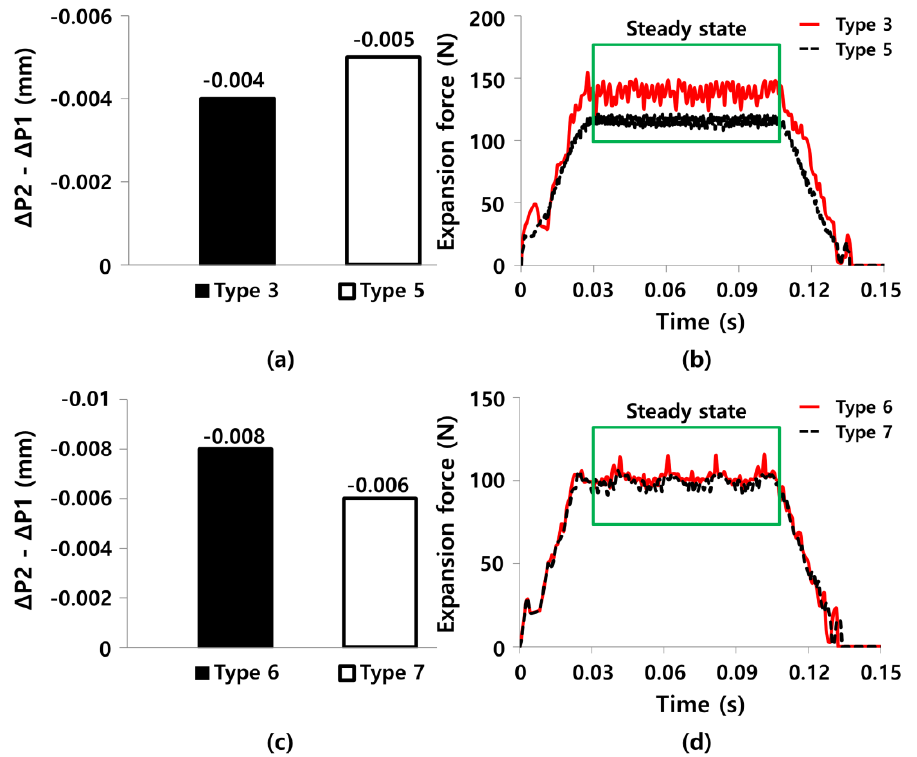
Figure 9. ( a ) ΔP2 − ΔP1 of Type 3 and 5 expansion balls and ( b ) their expansion force profiles; and ( c ) ΔP2 − ΔP1 of Type 6 and 7 expansion balls and ( d ) their expansion force profiles.